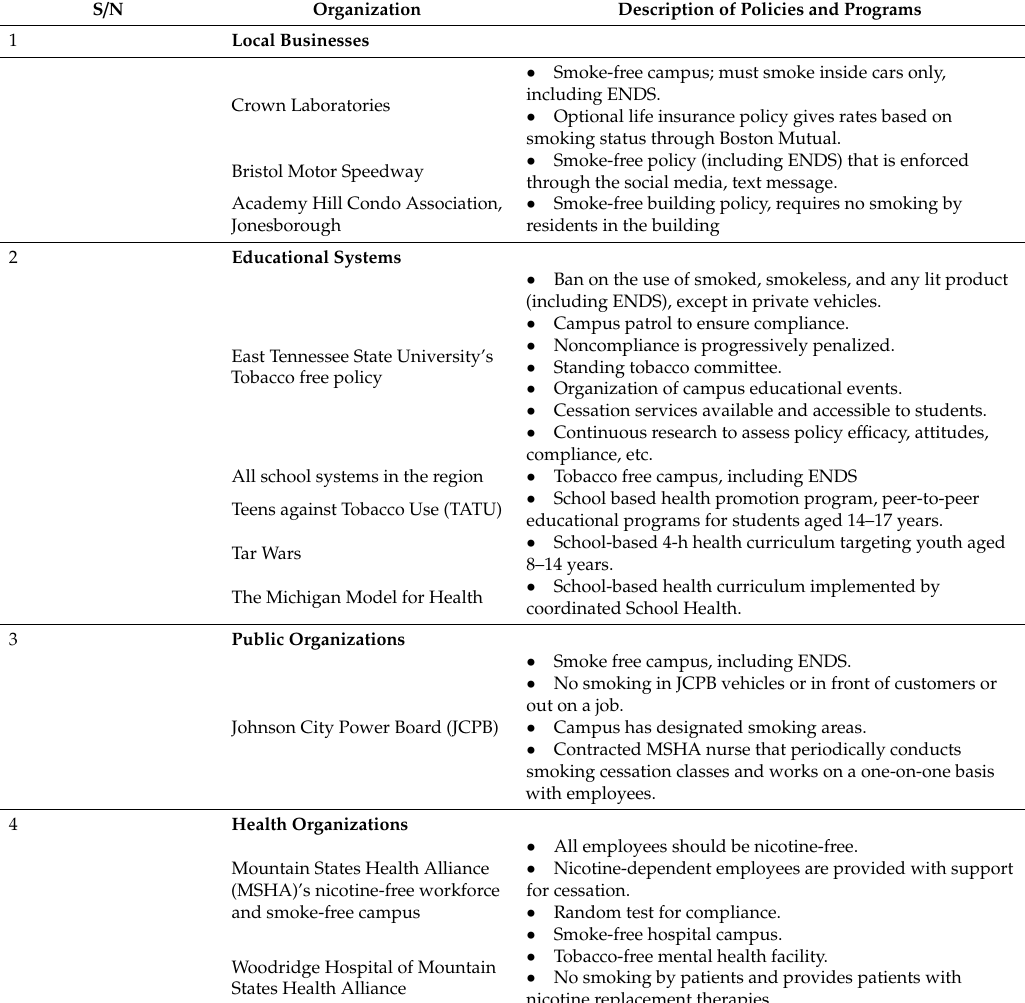
Table 2. Local Policies and programs in Central Appalachia during the Era of State Preemption In tobacco